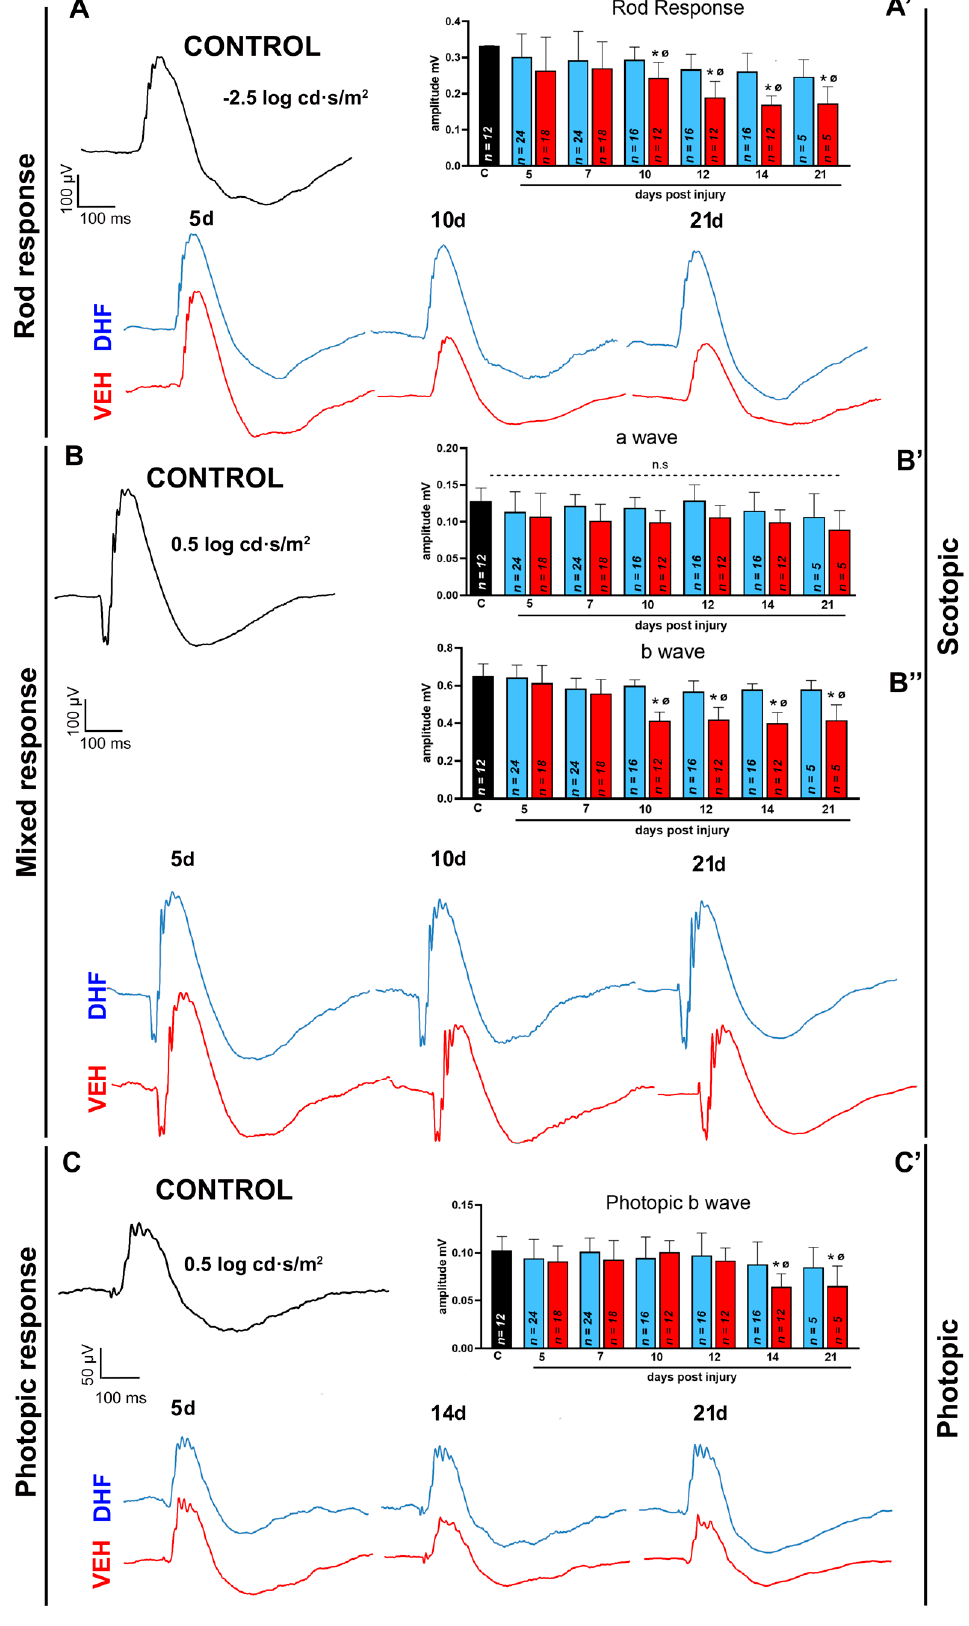
Figure 2. 7,8-Dihydroxiflavone fully prevents function loss of second order retinal neurons. Adult albino rats were treated daily with i.p. vehicle (VEH) (1% DMSO in 0.9% NaCl) or DHF (5 mg/kg) starting the day before left optic nerve